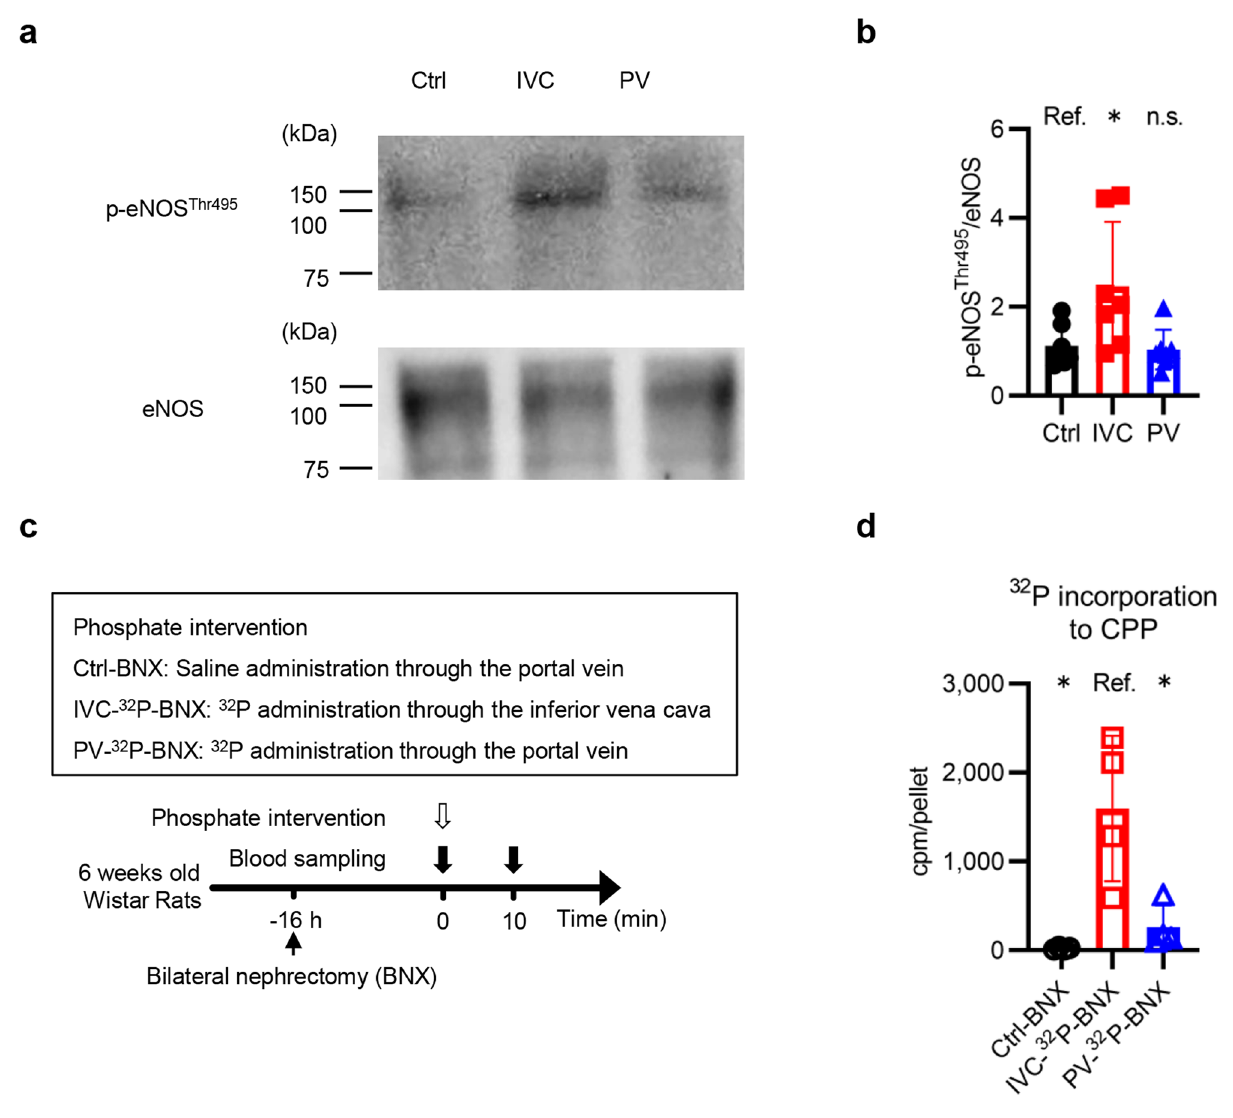
Figure 6. Phosphorylation of endothelial nitric oxide synthase (eNOS) and levels of phosphate incorporation to calciprotein particles (CPPs) were suppressed in the PV group. (a) Representative immunoblots of phosphorylated eNOS (Thr495) and total eNOS in the aorta. Aortic tissues were collected at 20 min in the rats shown in Fig. 2a. The original blots are presented in Supplementary Fig. S11. ( b ) Quantifying phosphorylated eNOS (Thr495) (n = 7 rats per group). ( c ) Experimental design of ( d ). Levels of phosphate incorporation to CPPs were analyzed. BNX rats were randomly divided into three groups, Ctrl-BNX, IVC- 32 P-BNX, and PV- 32 P-BNX. Sixteen hours after the BNX operation, rats in the Ctrl-BNX group were similarly administered normal saline to the rats in Ctrl group. Rats in the IVC- 32 P-BNX and PV- 32 P-BNX groups were administered a radiolabeled phosphate solution similar to those in IVC- 32 P and PV- 32 P groups. At 10 min, blood samples were collected from the inferior vena cava. After the separation of serum (1200 × g for 15 min), levels of 32 P in the pellet fraction (16,000 × g for 2 h) obtained from the serum were measured (n = 4 rats per group). All results are presented as the means ± SDs, n.s.: not significant, Ref: reference. * P < 0.05 based on Dunnett’s test in ( b ) and ( d